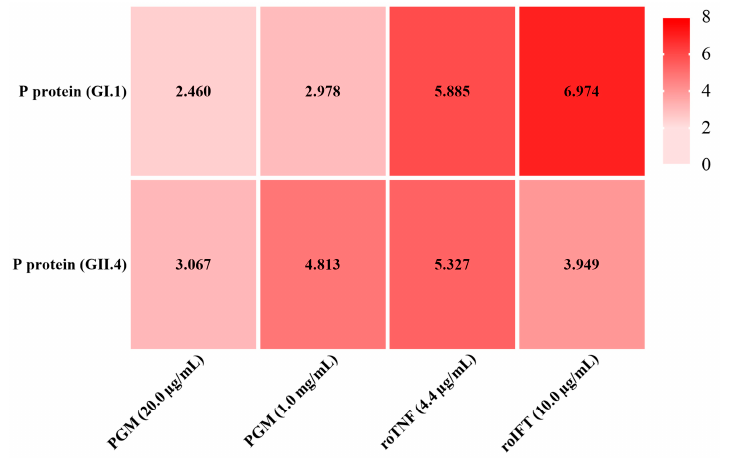
Figure 5. The binding ability of PGM, roTNF, and roIFT to GI.1 and GII.4 HuNoV P proteins, respectively. The OD450 of 1.0% BSA, negative control, was all less than 0.1. PGM was used as a positive control. Taking the criterion of positive to negative (P/N) of ≥ 2.0.